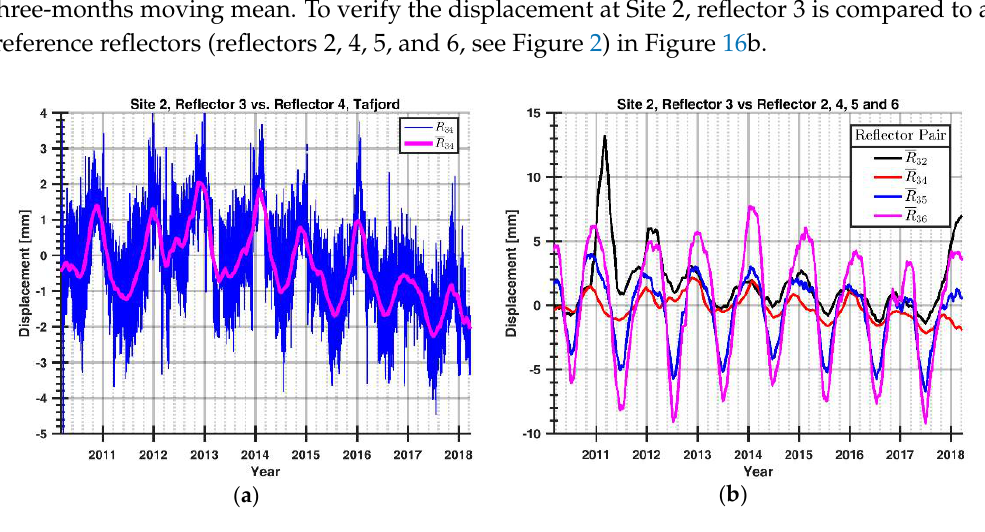
Table 4. Measured displacement of Reflector 1 at Site 1, referenced to the four reference reflectors.